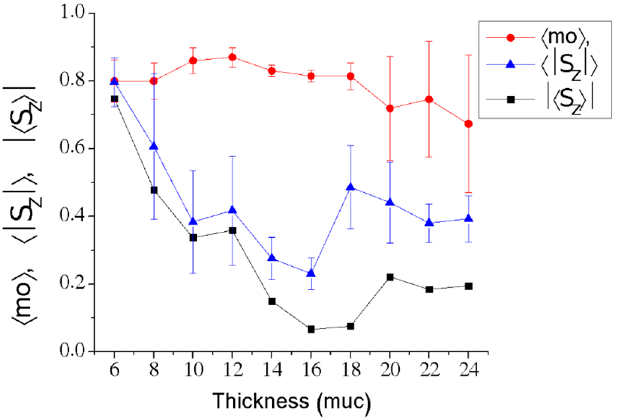
Figure 4. Dependence of (cid:104) m 0 (cid:105) , (cid:104)| S z |(cid:105) , and |(cid:104) S z (cid:105)| as a function of the thickness. The values indicate a transition of the perpendicular mono-domain at 6 muc to in-plane alignments at 16 muc, tending to a single domain per grain or set of grains.